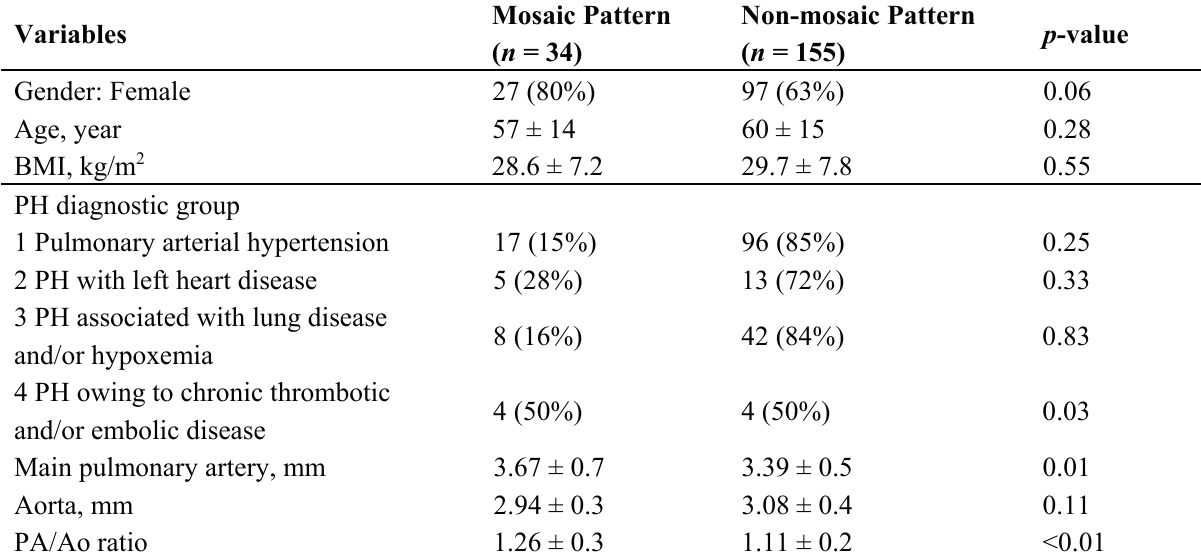
Table 2. Summary statistics of demographic and clinical variables by mosaic pattern of lung attenuation on chest CT scan